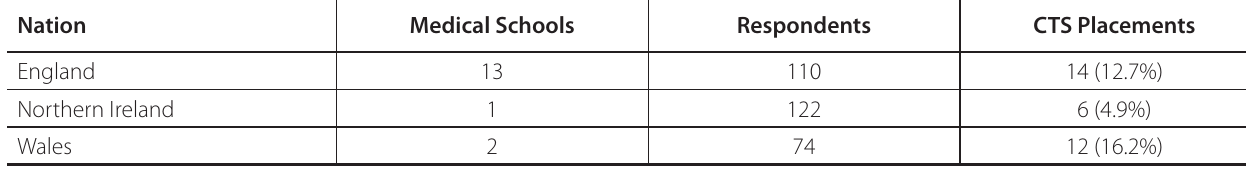
Table 2 . Breakdown of graduate origins and cardiothoracic placements.